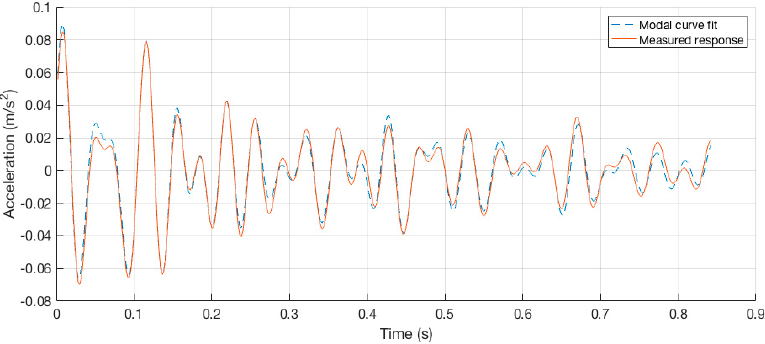
Figure 12. Modal curvefitting of the signal.